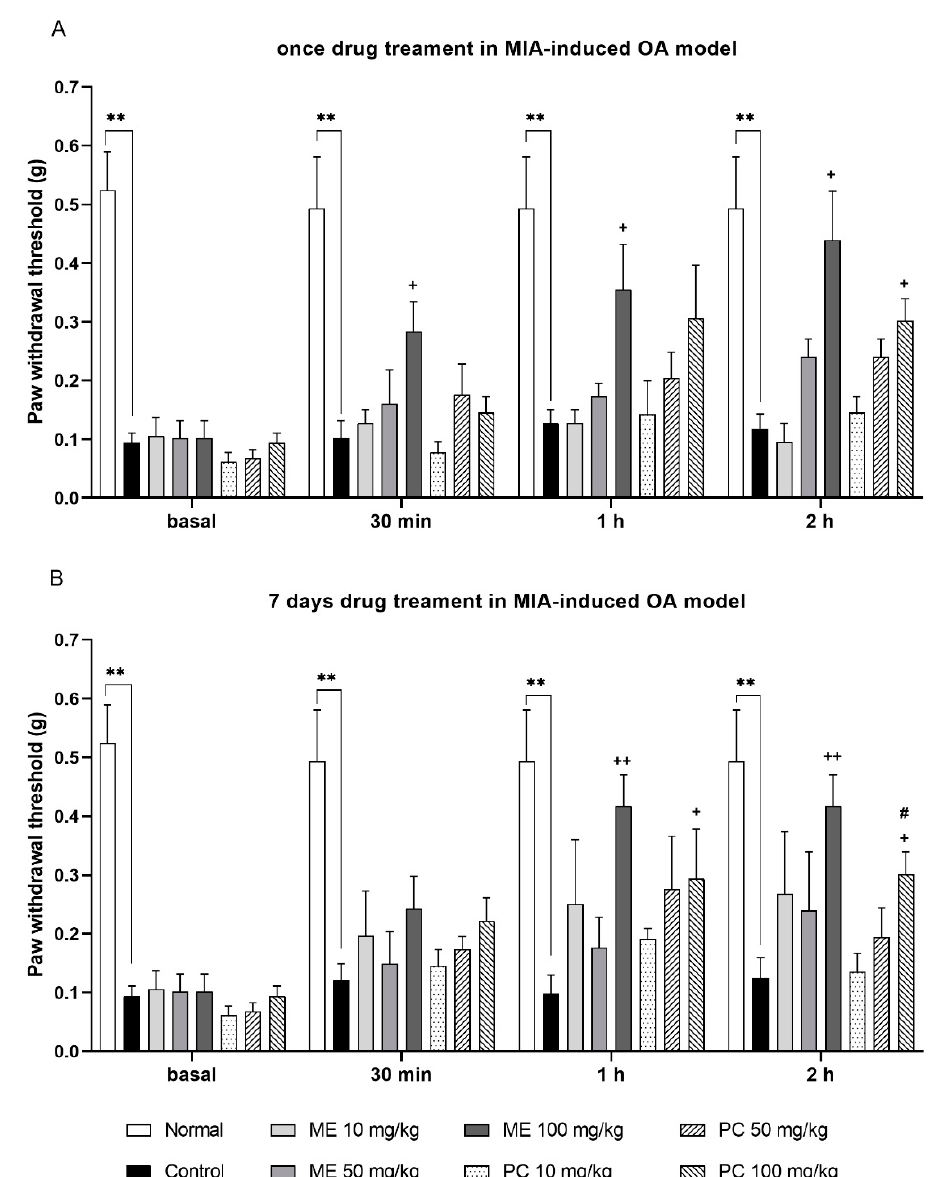
Figure 2. The antinociceptive effect of ME and PC administered orally in the MIA-induced OA model. Mice were administered orally with the vehicle, ME (from 10 to 100 mg/kg), or PC (from 10 to 100 mg/kg), and then were measured for pain threshold at 30, 60, and 120 min after treatment using the von-Frey test. ( A ) Mice were treated with the vehicle, ME, or PC once (basal: Normal vs. Control p = 0.0073; 30 min: Normal vs. Control p = 0.0089, Control vs. ME 100 mg/kg p = 0.0313; 1 h: Normal vs. Control p = 0.0095, Control vs. ME 100 mg/kg p = 0.0182; 2 h: Normal vs. Control p = 0.0084, Control vs. ME 100 mg/kg p = 0.0137, Control vs. PC 100 mg/kg p = 0.0423). ( B ) Mice were administered orally with the vehicle, ME, or PC for 1 week (basal: Normal vs. Control p = 0.0067; 30 min: Normal vs. Control p = 0.0099, Control vs. ME 100 mg/kg p = 0.0313; 1 h: Normal vs. Control p = 0.0089, Control vs. ME 100 mg/kg p = 0.0098, Control vs. PC 100 mg/kg p = 0.0159; 2 h: Normal vs. Control p = 0.0085, Control vs. ME 100 mg/kg p = 0.0098, Control vs. PC 100 mg/kg p = 0.0276, ME 100 mg/kg vs. PC 100 mg/kg p = 0.0463). The values denote the mean ± SEM ( n = 5). The repeated measurement two-way ANOVA analyzed each quantified result with a Tukey’s post hoc test. ** p < 0.01; + p < 0.05, ++ p < 0.01; # p < 0.05.